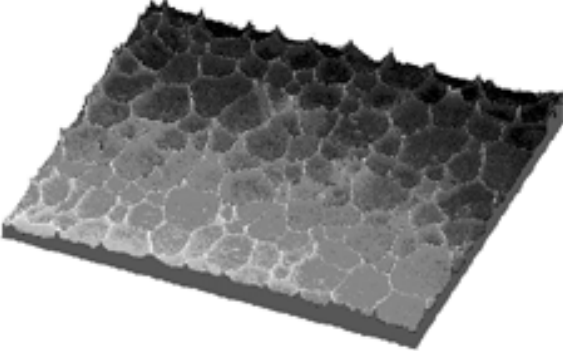
Figure 3. 3D representation of the gray level image of Fig. 1.